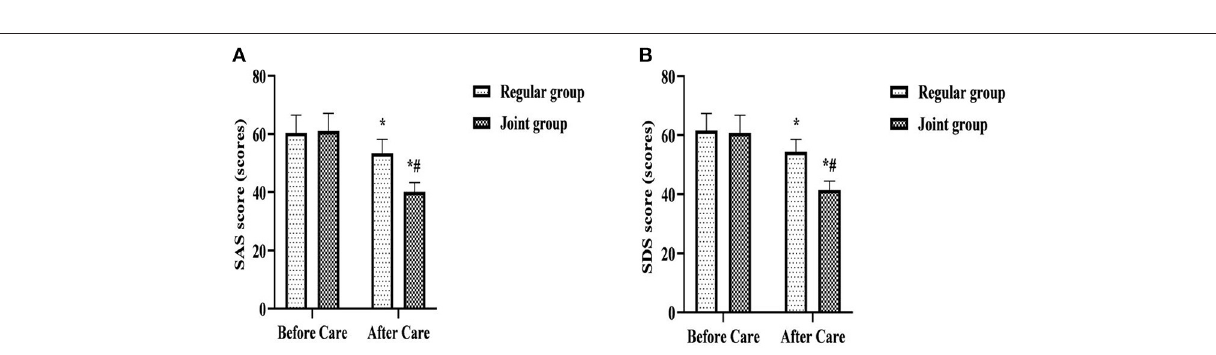
FIGURE 3 | Comparison of SAS and SDS scores of the two groups. (A) SAS score; (B) SDS score. Compared with the same group before care, * P < 0.05; Compared with the regular group after care, # P < 0.05.